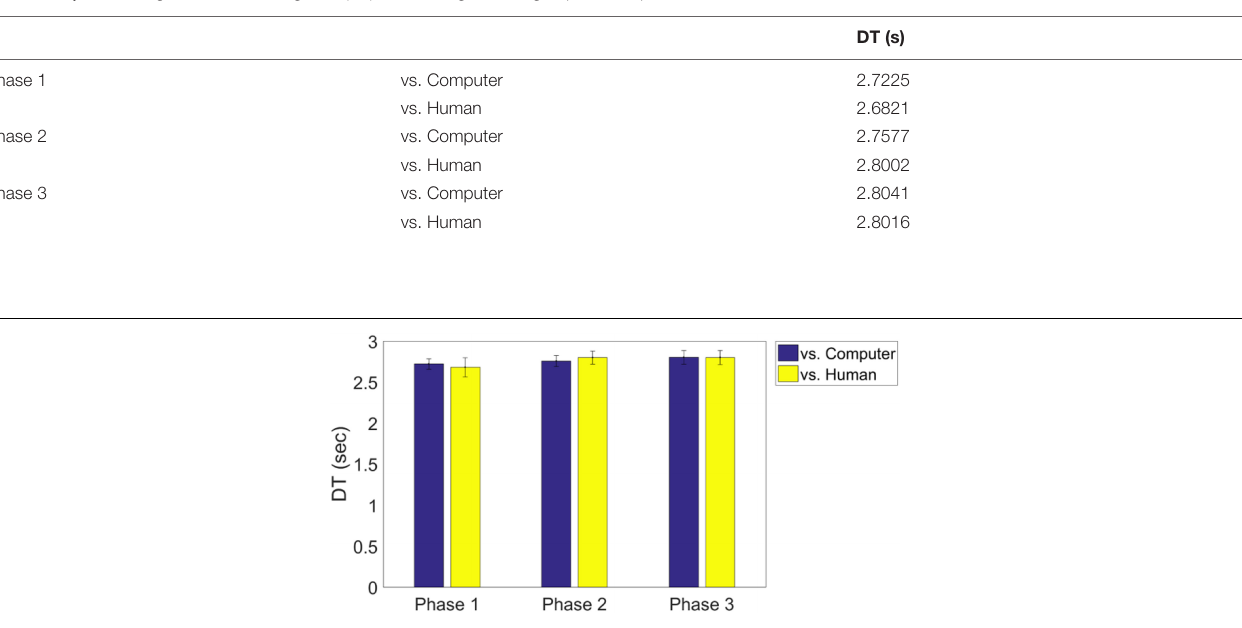
FIGURE B1 | The average decision-making time (DT) of each group (human-opponent and computer-opponent) in each phase. Note that participants should respond within 3 s if they decide to avoid.